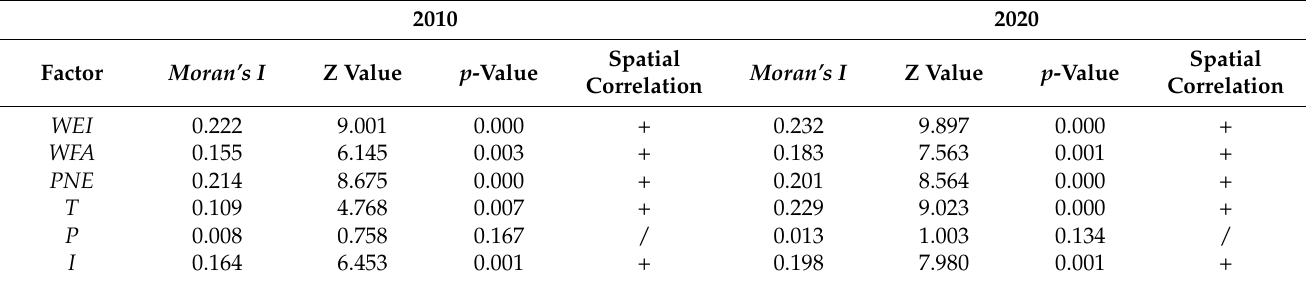
Table 5. Global Moran’s I test of influencing factors for wheat production in the HHH from 2010 to